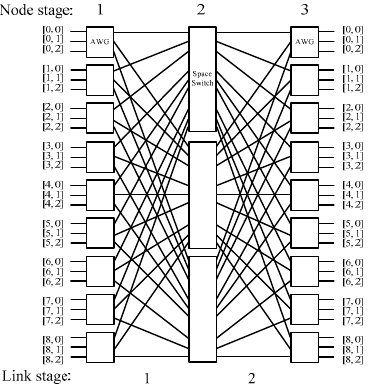
Figure 3. An A(3, 3, 9) switch.